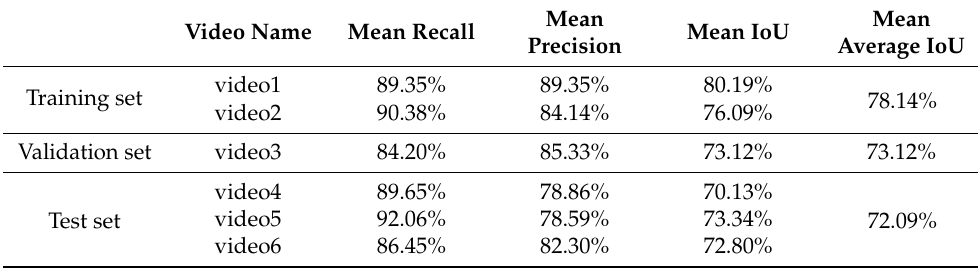
Table 3. Results of the fine detection network.